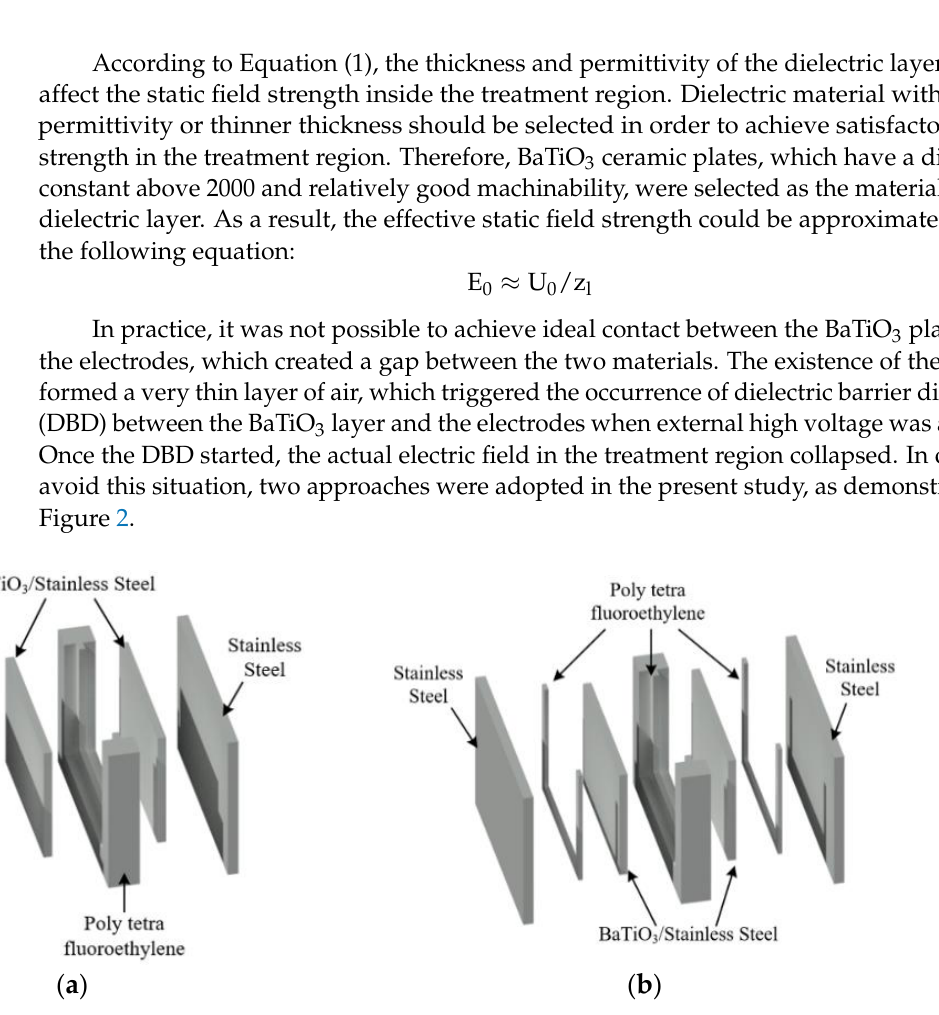
Figure 2. Schematic of the PEF chamber designs. ( a ) Chamber with BaTiO 3 plates and electrodes joined together using silver paste; ( b ) Chamber with extended gaps between BaTiO 3 plates and elec- trodes.